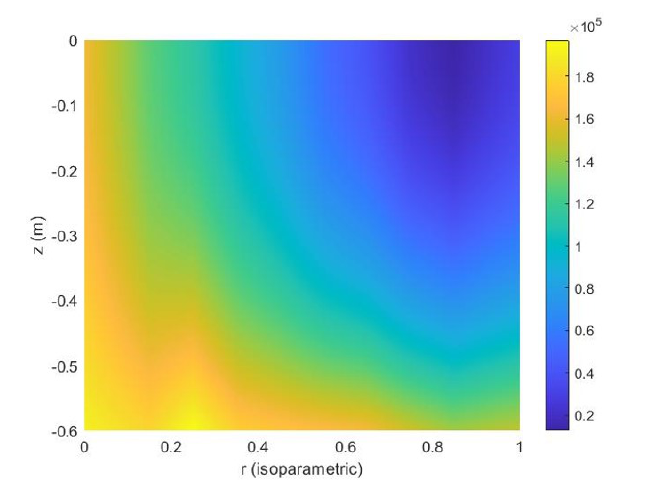
Figure 12. Map of energy loss per unit volume of conductor (J/m 3 ) during one